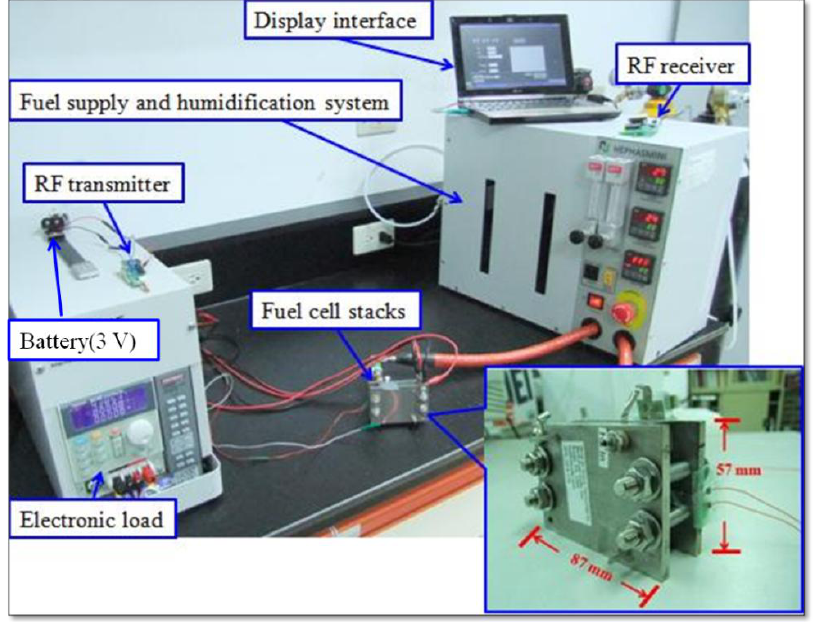
Figure 9. Photo of fuel cell operating system and wireless sensing system.